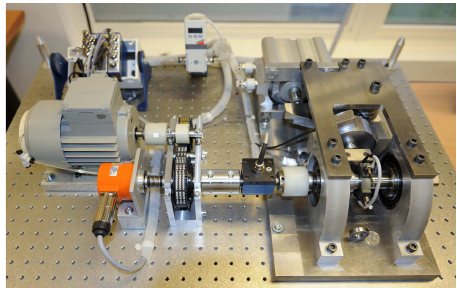
Figure 8. Overview of the PRONOSITIA [34].